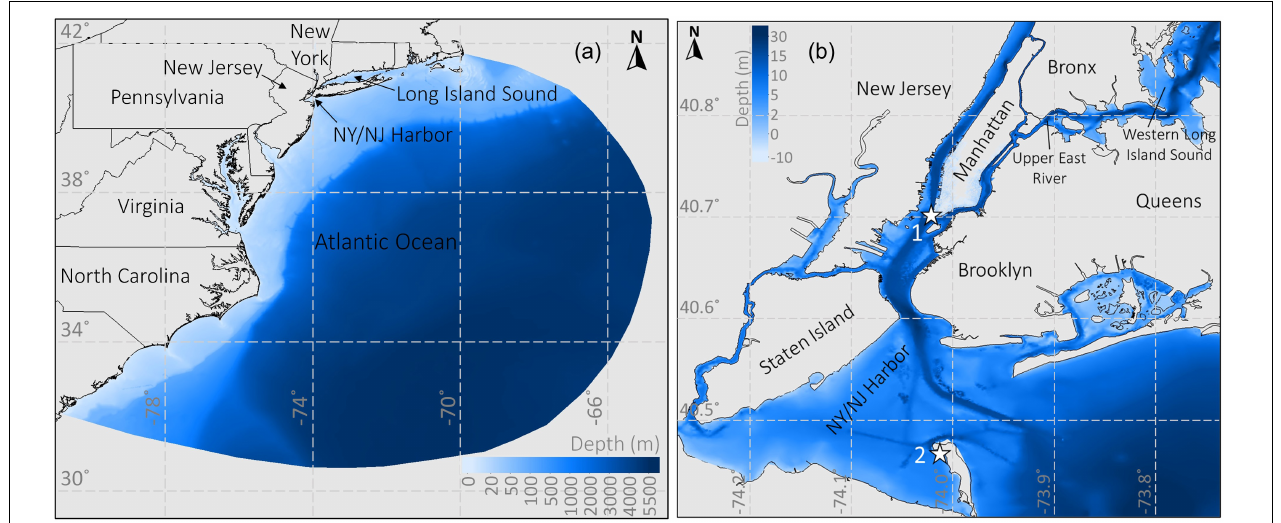
FIGURE 1 | The extent and bathymetry of the computational domain in (a) Atlantic Ocean and (b) NY/NJ Harbor. Star signs labeled as 1 and 2 represent, respectively, the locations of The Battery and Sandy Hook tide gauge stations.